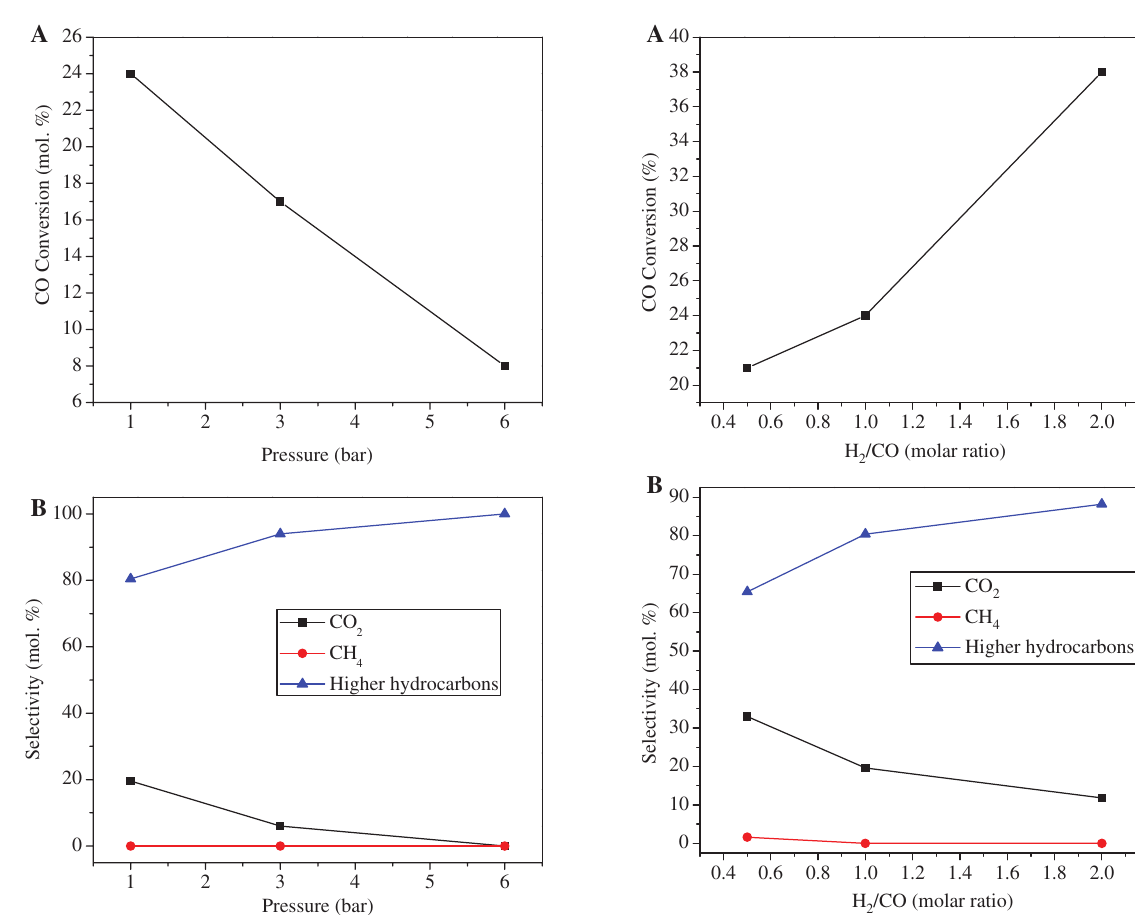
/CO molar ratio on FTS. (A) Conversion; Figure 8 Influence of H 2 /CO in 2